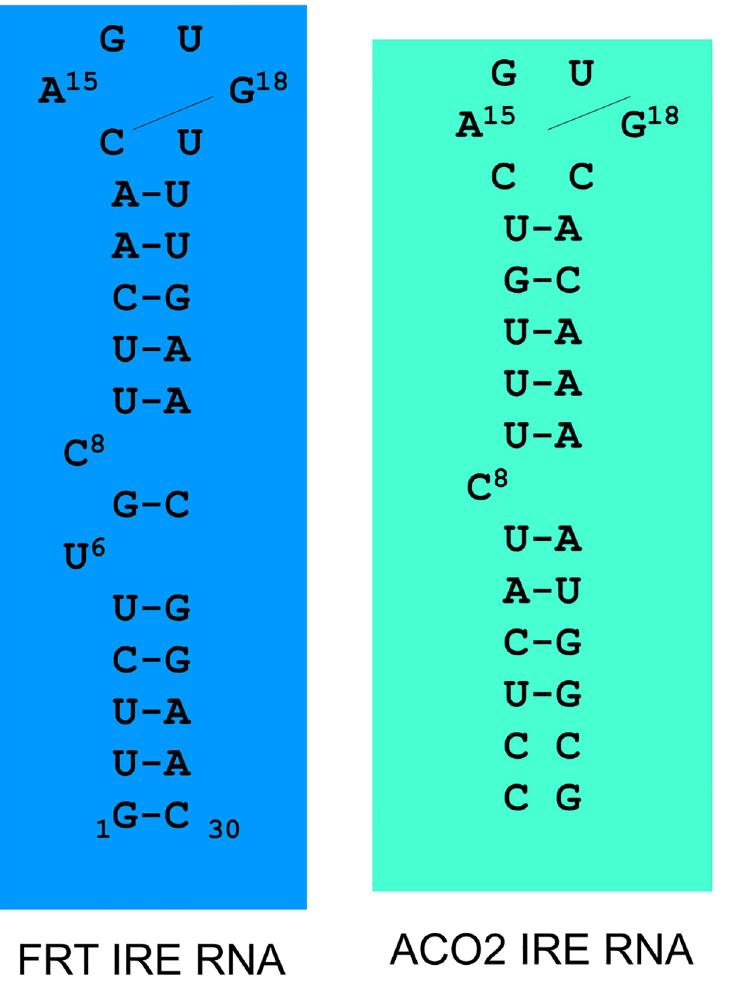
Fig 1. Secondary structures of ferritin and mitochondrial aconitase